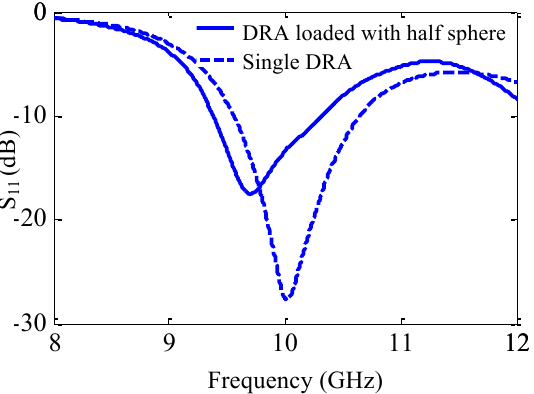
Figure 7: Reflection coefficient versus frequency for DRA loaded with lower half dielectric sphere compared to single DRA.